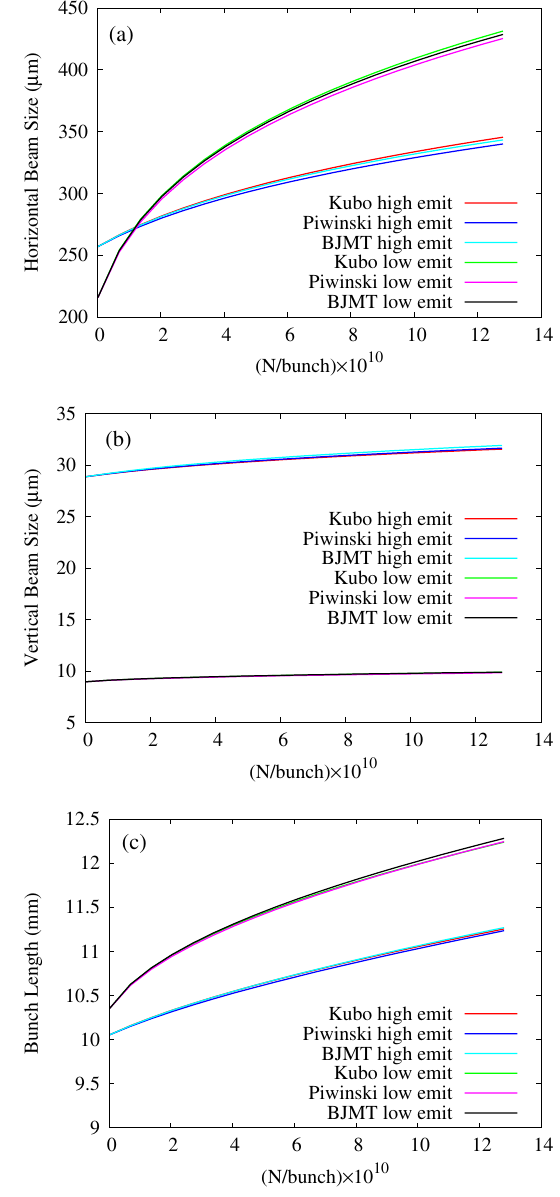
FIG. 5. Comparing (a) horizontal, (b) vertical, and (c) longitudinal beam size versus current for Kubo’s, Piwinski’s, and the Bjorken-Mtingwa (BJMT) IBS formalisms. The high ¼ 4 : 6 nm (cid:7) rad , (cid:5) ¼ 14 : 3 pm (cid:7) rad , emittance lattice has (cid:5) x 0 y 0 ¼ 10 : 0 mm . The low-emittance lattice has (cid:5) ¼ and (cid:8) z 0 x 0 ¼ 1 : 5 pm (cid:7) rad , and (cid:8) ¼ 10 : 3 mm 2 : 8 nm (cid:7) rad , (cid:5) y 0 z 0